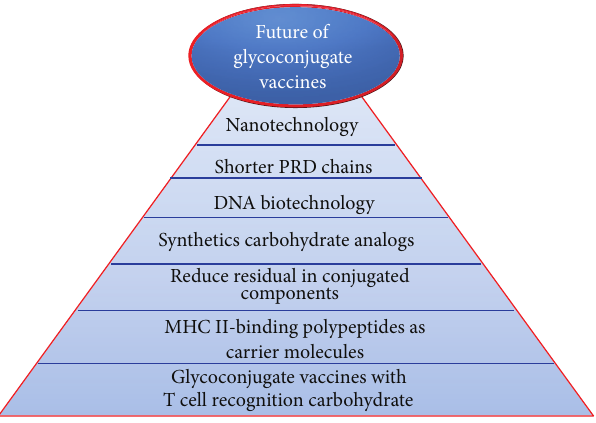
Figure 7: The most important approaches to improve glycoconju- gate